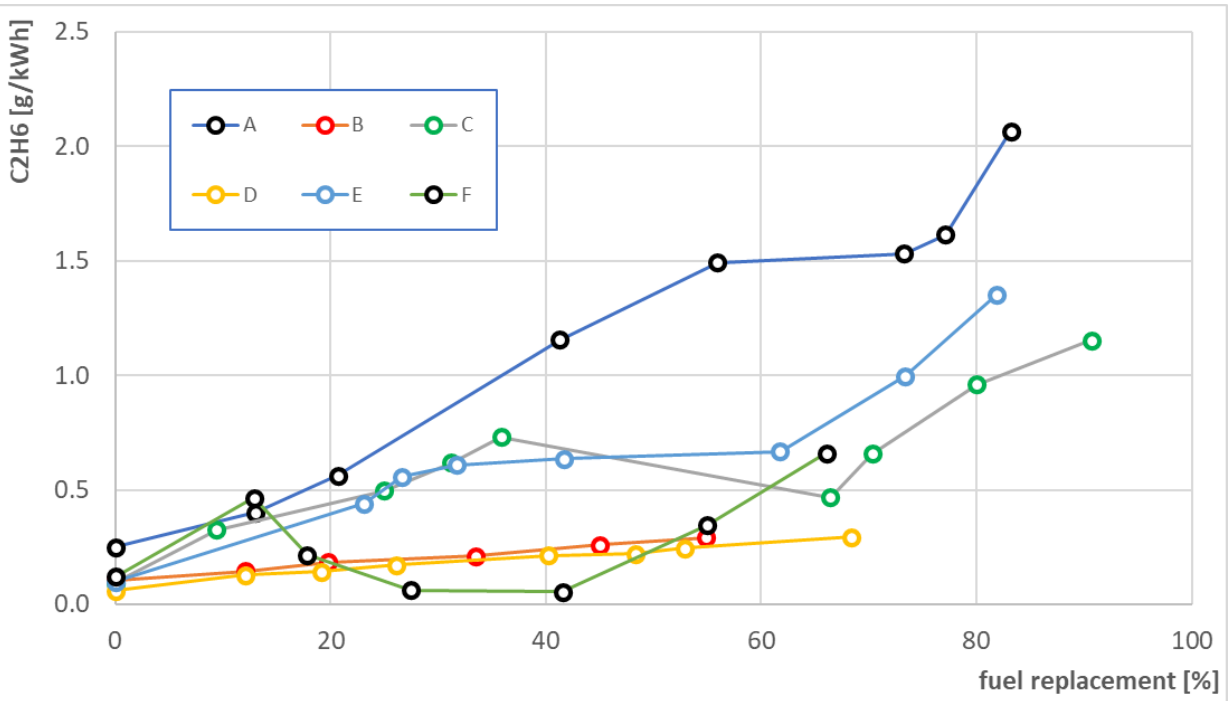
Figure 13. Curves from A to F showing the engine’s emission of C 2 H 6 (ethane), for individual engine operating points, where the rotation speed, power, and torque were constant, as a replacement function of diesel fuel replaced by